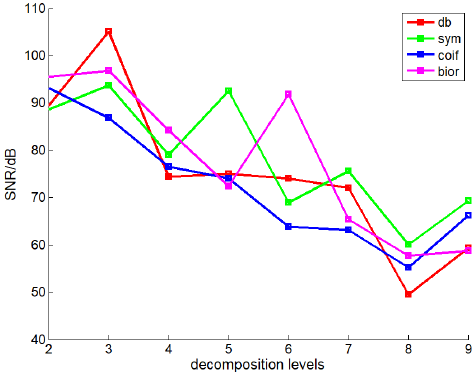
Figure 5. De-noised results for four types of wavelet bases.